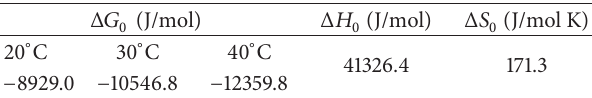
Table 6: Thermodynamic parameters of the lead adsorption process